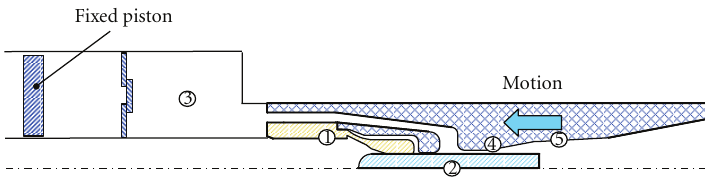
Figure 1: Schematic representation of self-blast circuit breaker geometry.